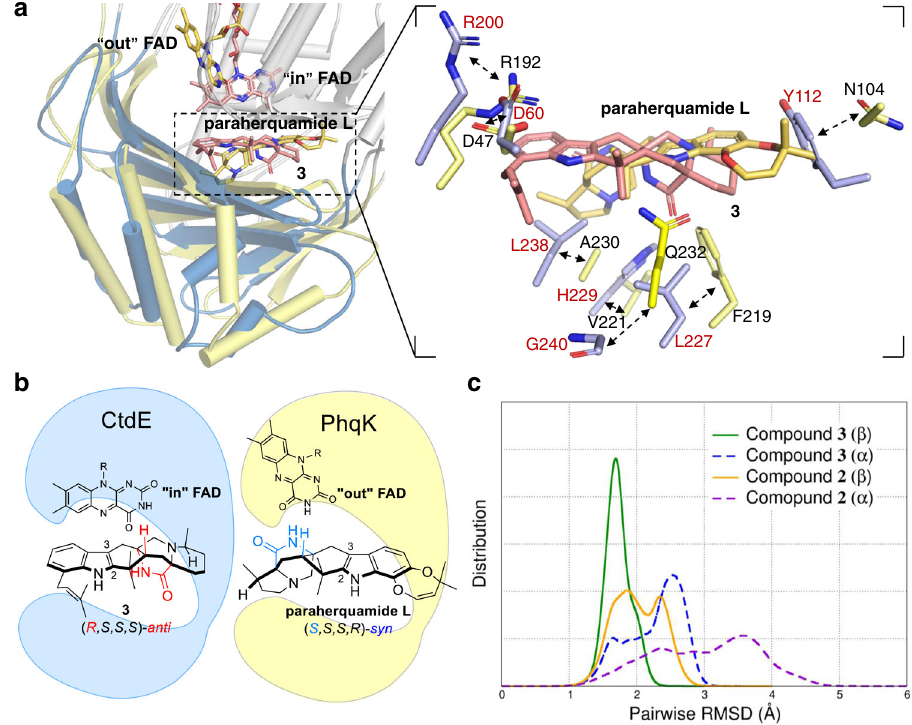
Fig. 6 Comparison of the different facial selectivity in CtdE and PhqK. a Overlay structures of CtdE – FAD- 3 and PhqK – FAD – substrate complexes and their substrate-binding view of 3 ( 3 is shown as red carbons, while paraherquamide L is shown as orange carbons. CtdE is shown in blue, while PhqK is shown in yellow). b Comparison of the stereochemistry of CtdE and PhqK substrates. c The pairwise RMSD of protein backbone atoms over time of CtdE substrates 2 and 3 , respectively. ( β and α represent the positions of FAD on the β - and α -face of the substrate,